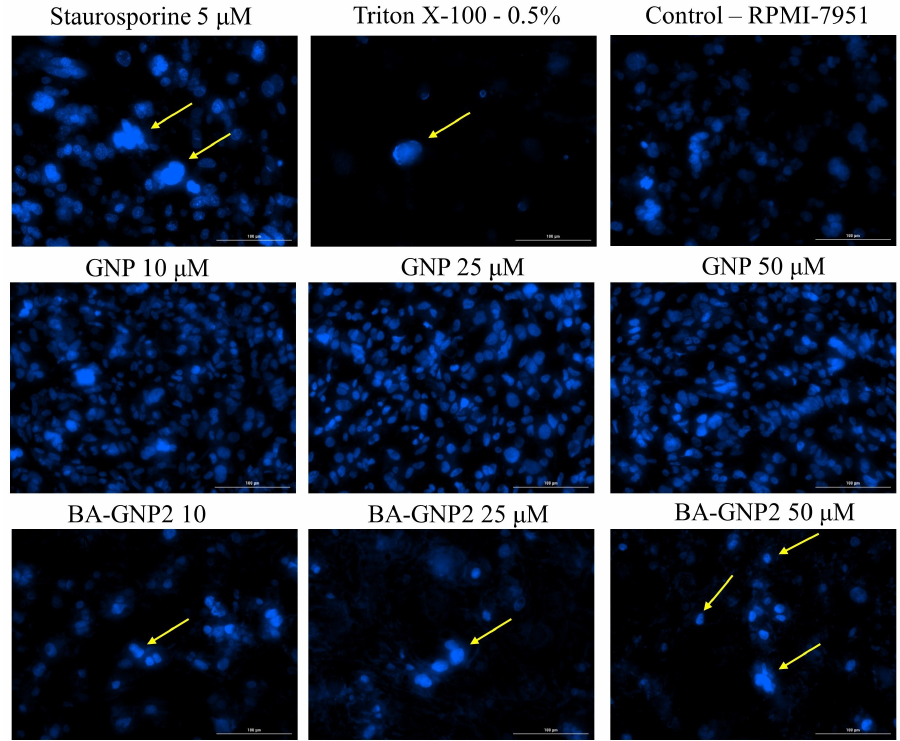
Figure 10. Nuclear staining using DAPI in RPMI-7951 cells after treatment with GNP (diluted to match the same gold content as for BA-loaded NPs at 10, 25 and 50 μΜ ) and BA-GNP treatment (10;